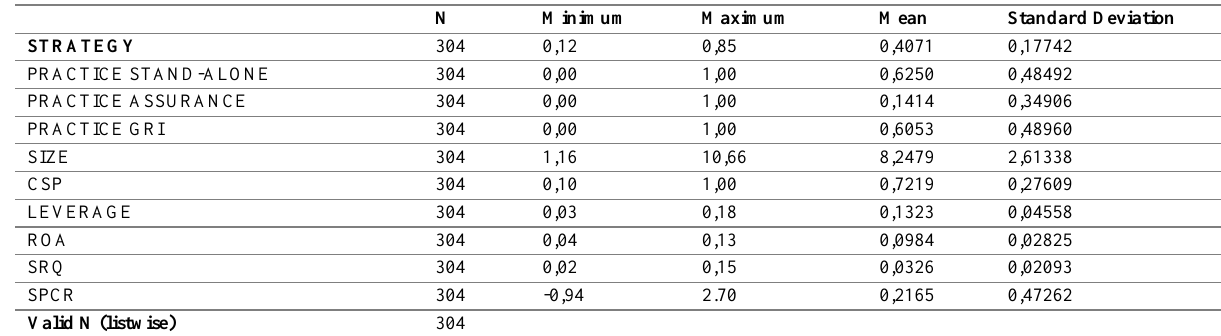
Table 6: Descriptive